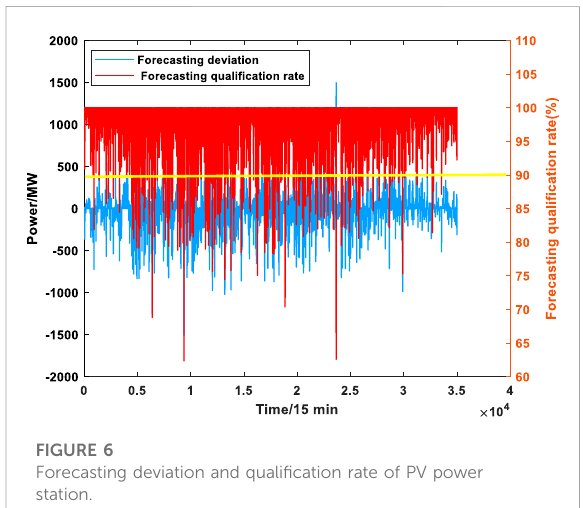
FIGURE 6 Forecasting deviation and quali fi cation rate of PV power station.